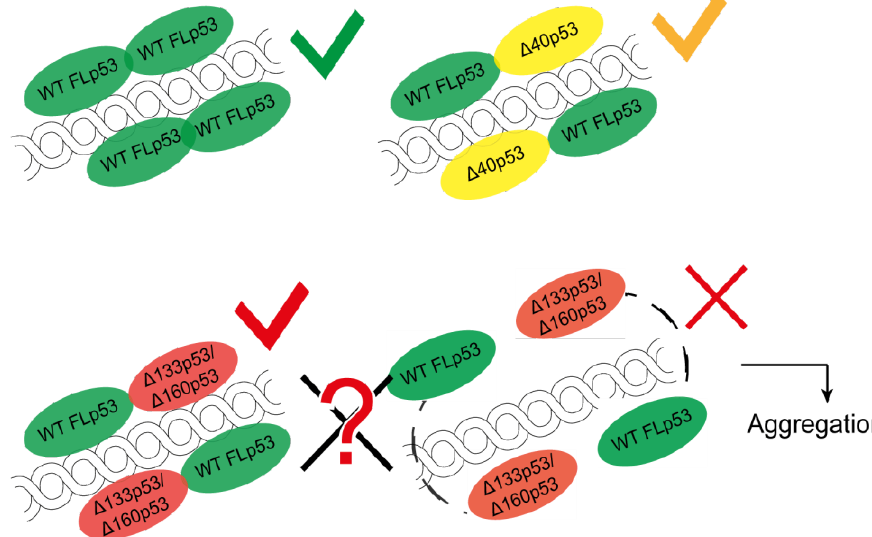
Figure 4. Possible modes of action of the p53 isoforms with respect to gene activation. Binding of FLp53-homotetramers to DNA response elements leads to activation of the standard gene repertoire.